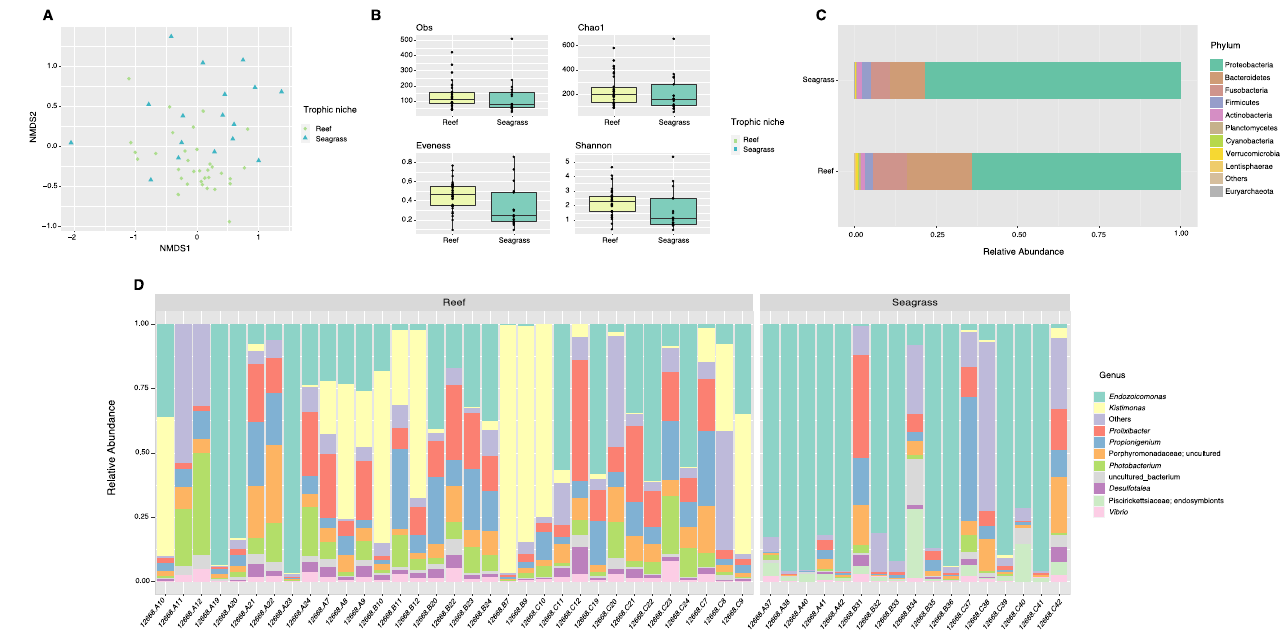
Figure 3. Diversity analyses comparing spine microbiota of sea urchin trophic niches (animals collected in the reef or among seagrass). Bray–Curtis analysis, represented by an NMDS (stress 0.1943077), ANOSIM p -value = 0.001 ( A ). Alpha diversity exhibits significant differences (p val < 0.05) in alpha diversity (Shannon) and evenness between trophic niches ( B ). Species-relative abundance of top ten taxa at phyla ( C ) and genus levels ( D ) are depicted by the barplots. Refer to Supplementary Table S3 for significant p -values.